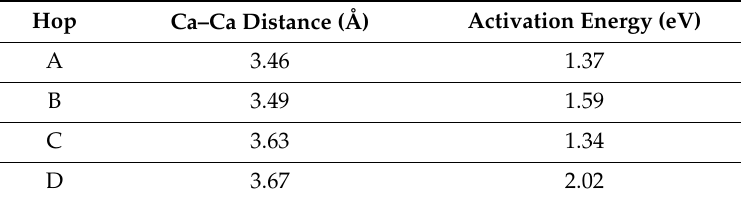
Table 4. Long-range Ca ion diffusion paths and their activation energies.